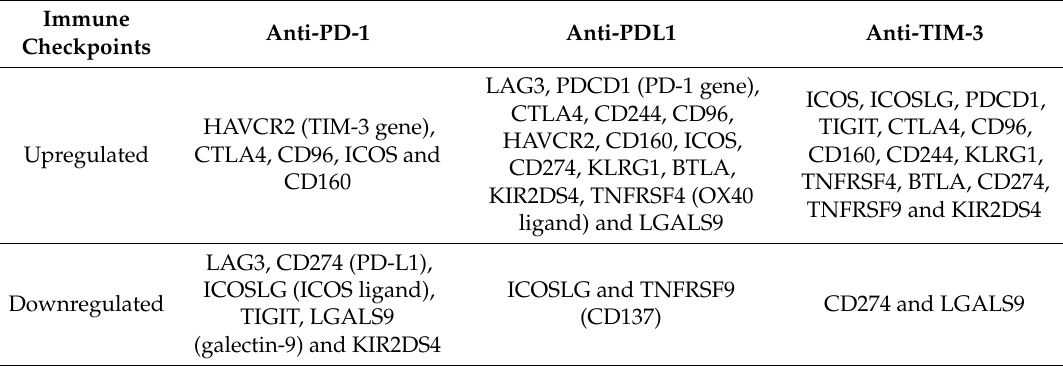
Table 1. Di ff erentially expressed immune checkpoints (receptors and ligands) in tumor-infiltrating immune cells from breast tumor explants in response to anti-PD-1, PD-L1, or anti-TIM-3 compared to non-treated